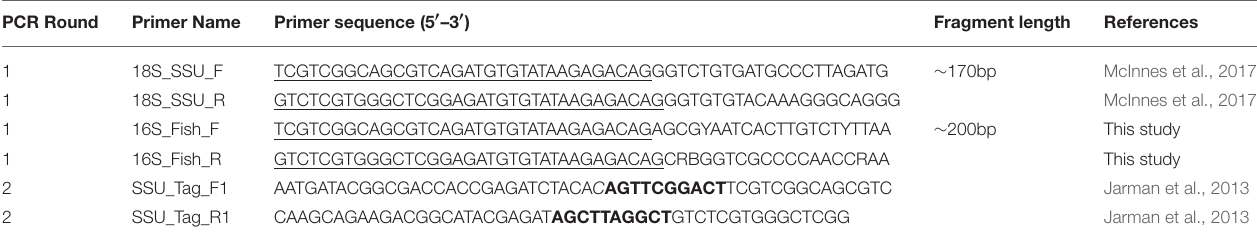
TABLE 2 | Oligonucleotides used in this